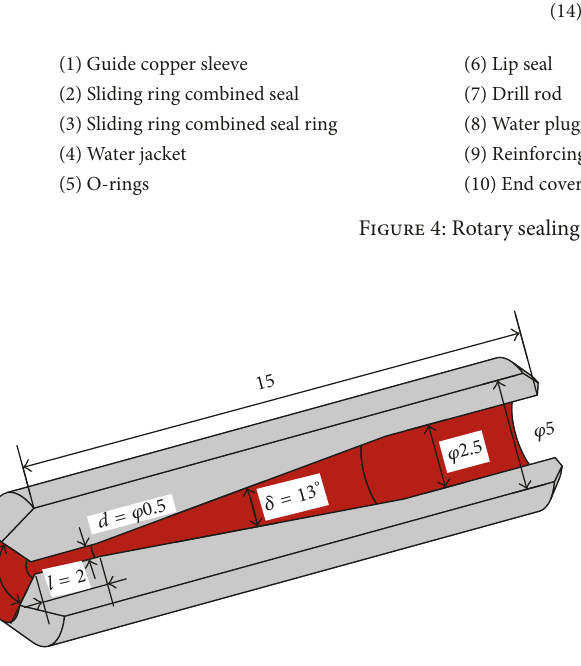
Figure 5: Nozzle structure and dimensions (mm).